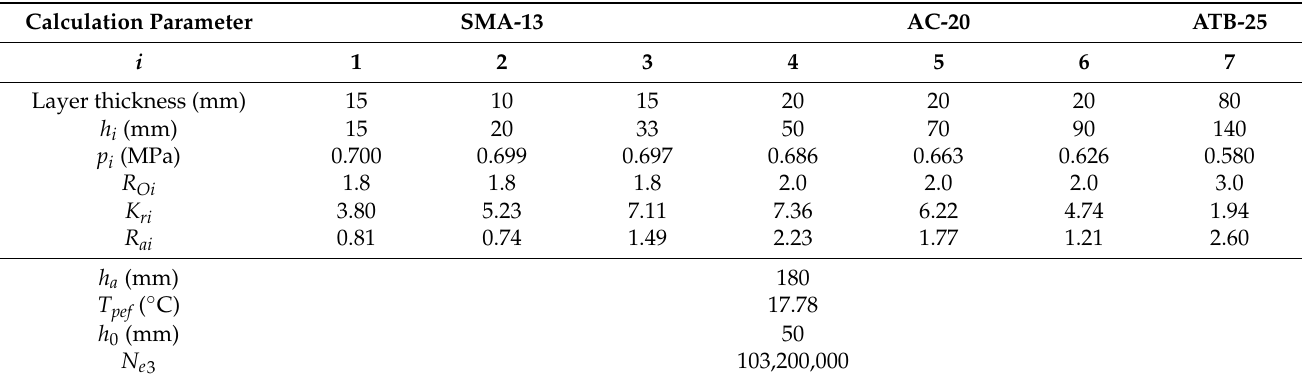
Table 23. Permanent deformation prediction model parameters for the HMA